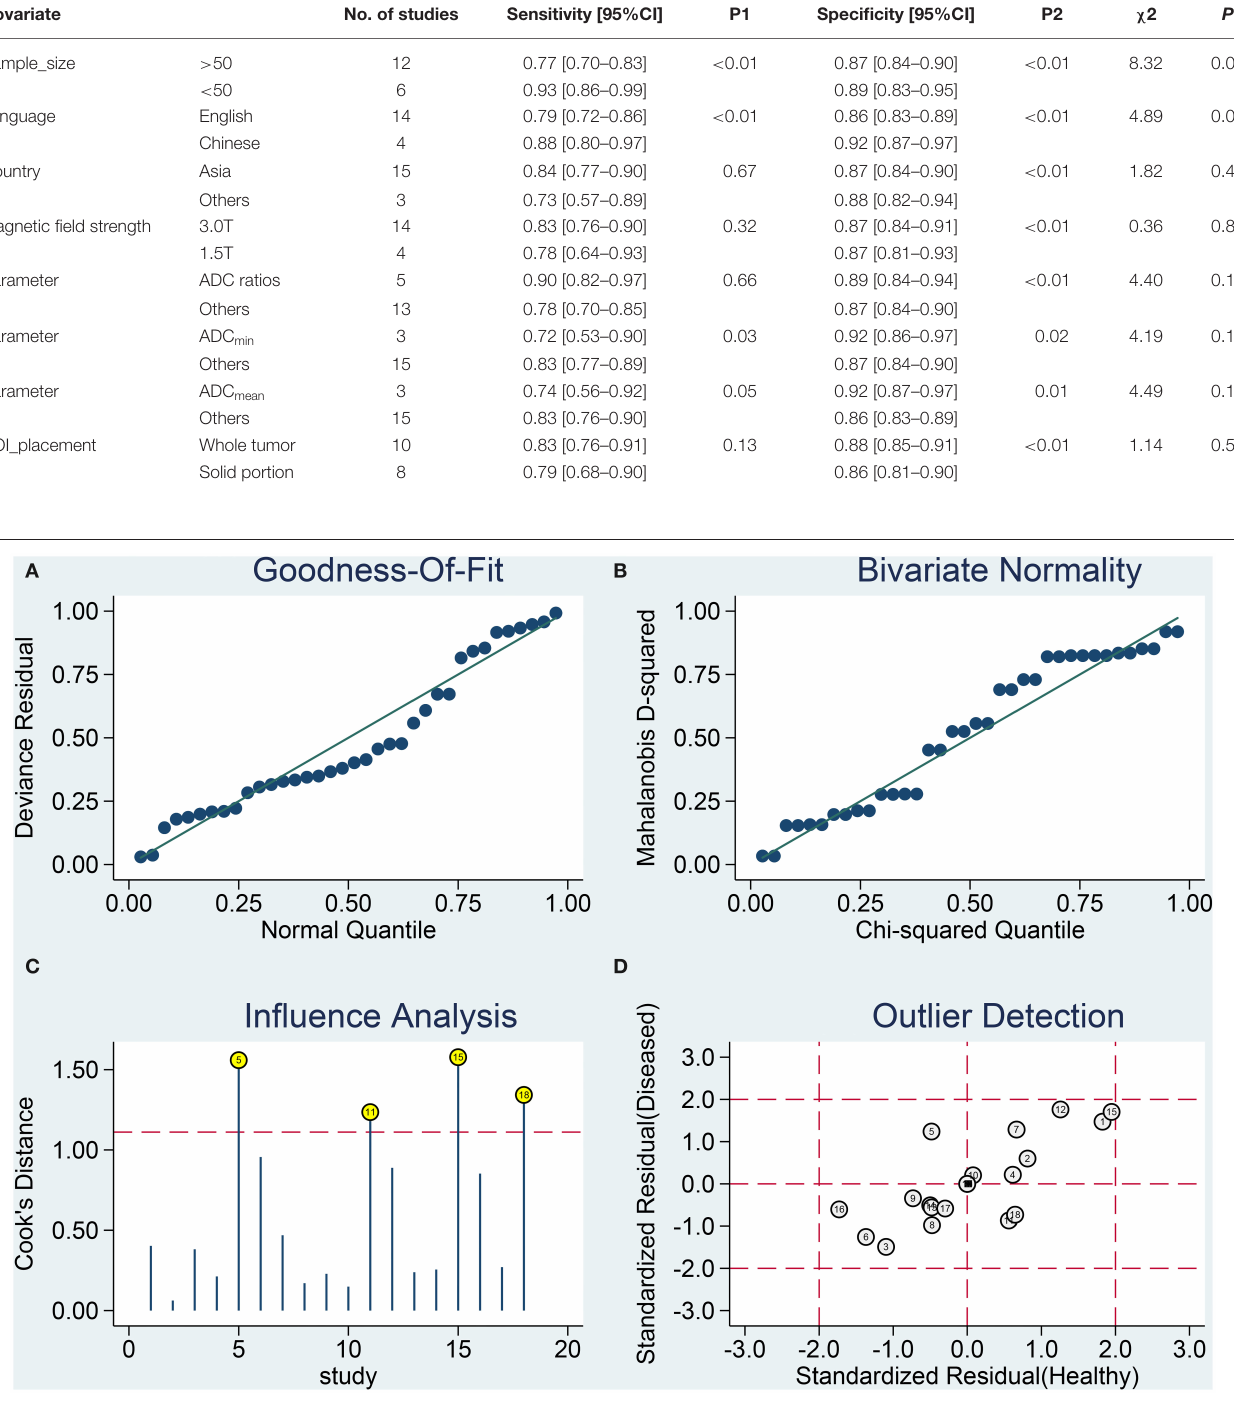
heterogeneity was observed, and the combined sensitivity, specificity, and other indicators were lower than those reported by us